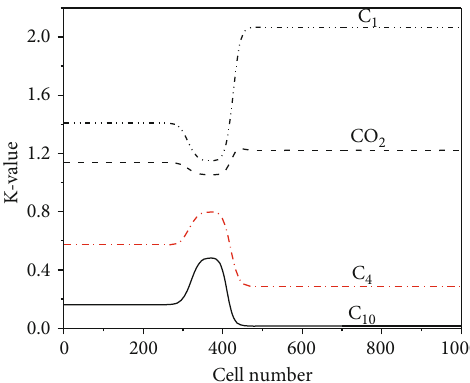
Figure 6: K -value pro fi le along the slim tube for Case 1b at 15.6 MPa (2262psia) and 71.1 ° C (160 ° F) after all tie lines are developed.